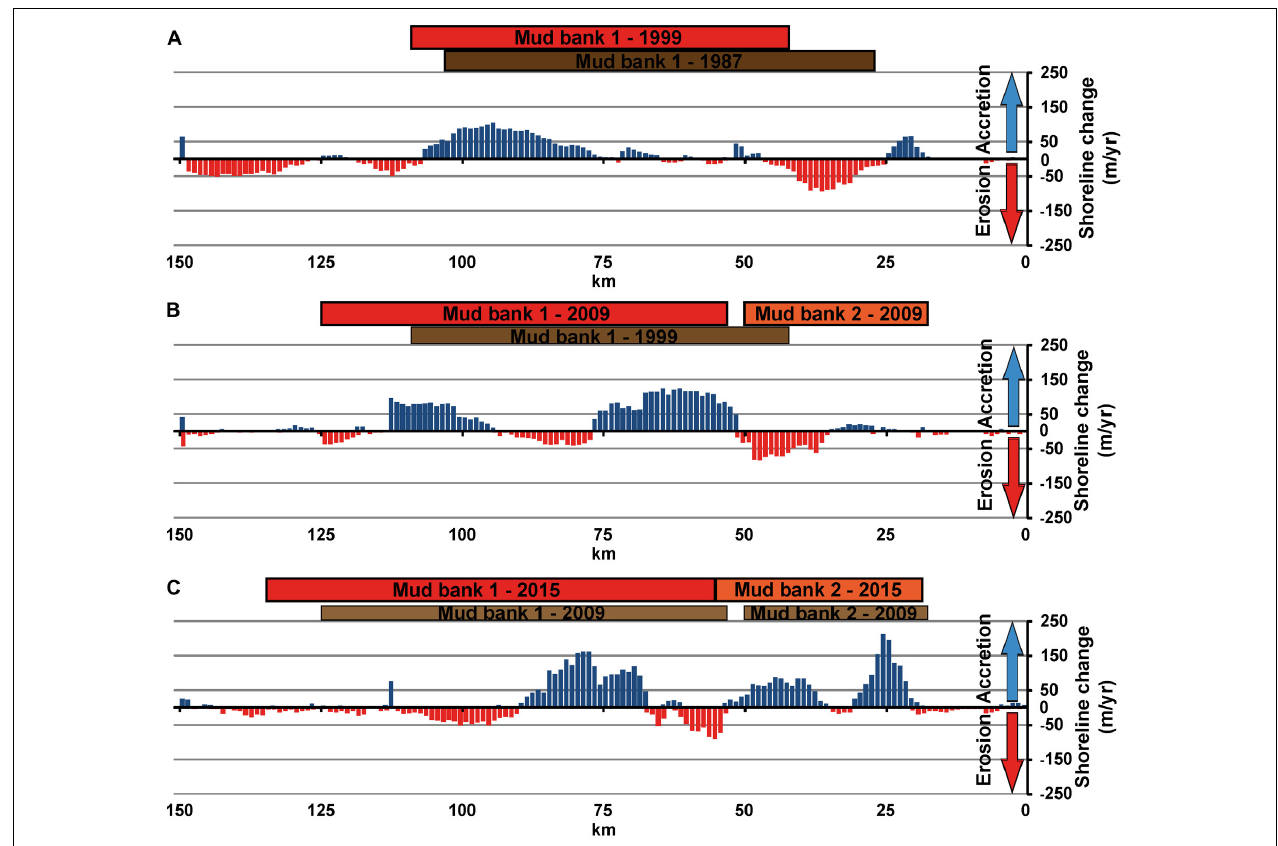
FIGURE 5 | Graphs of analyzed shoreline changes between the Maroni and the Suriname Rivers (October 1987 to October 2015) depicting the inordinately large erosion and accretion rates affecting the Guianas coast: (A) between 1987 and 1999; (B) between 1999 and 2009; (C) between 2009 and